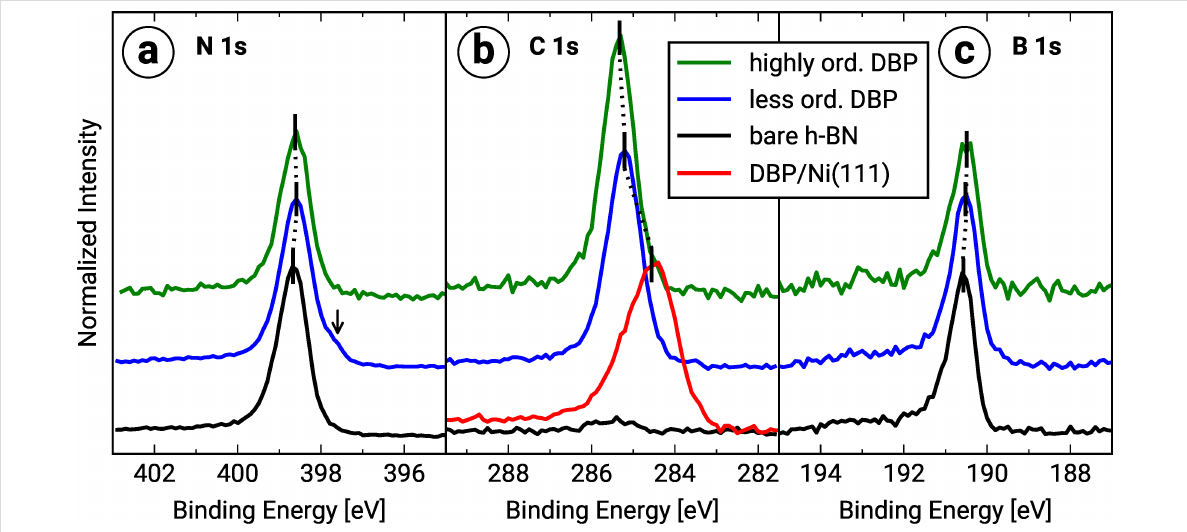
Figure 5: (a) N 1s, (b) C 1s, and (c) B 1s X-ray photoelectron spectra of DBP on bare Ni(111) (approx. 1.0 MLE) as well as of h-BN on Ni(111), and of DBP on h-BN/Ni(111) (less ordered (approx. 1.0 MLE) and highly ordered (approx. 1.6 MLE)). The intensity is normalized to the peak maxima of the N 1s core levels and corrected according to the photoionization cross sections of Yeh and Lindau [44]. For each spectrum the binding energy of the core level is marked by vertical black lines. The black arrow points to an unassigned second component of the N 1s level of the less ordered DBP layer on h-BN/Ni(111).